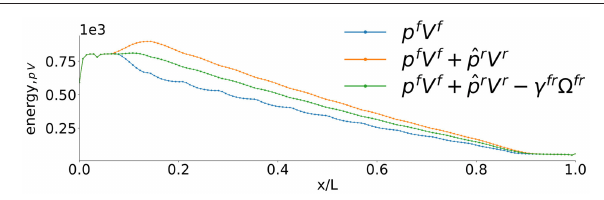
FIGURE 10 | Compressional energy pV variation across the system smoothed over the representary elementary